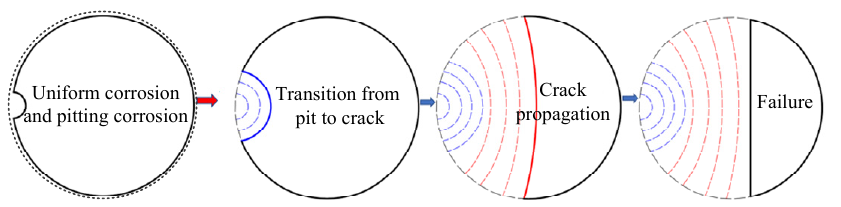
Figure 8. Degradation of suspender steel wires.